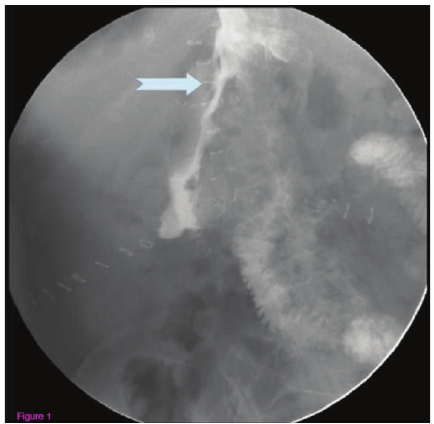
Figure 1: Gastrografin esophagography showing a 2 cm fistula at the anastomosis.